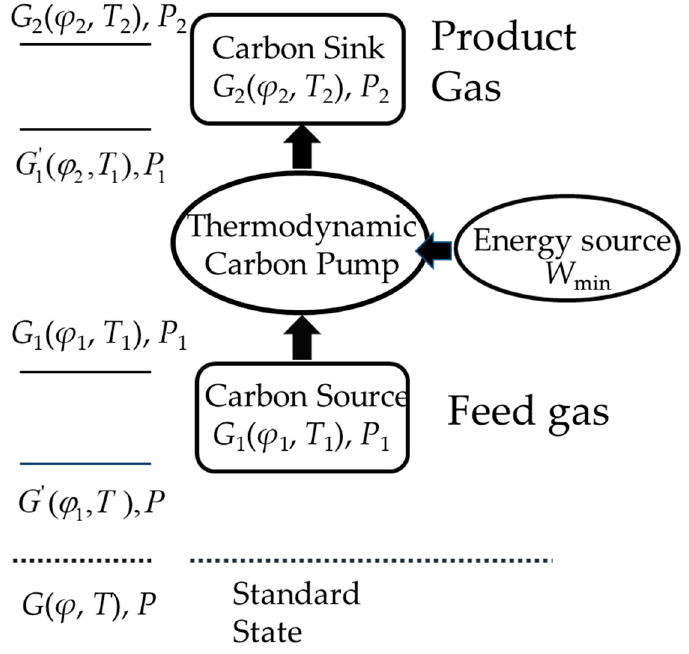
Figure 5. Concept and expression of COP CO2.